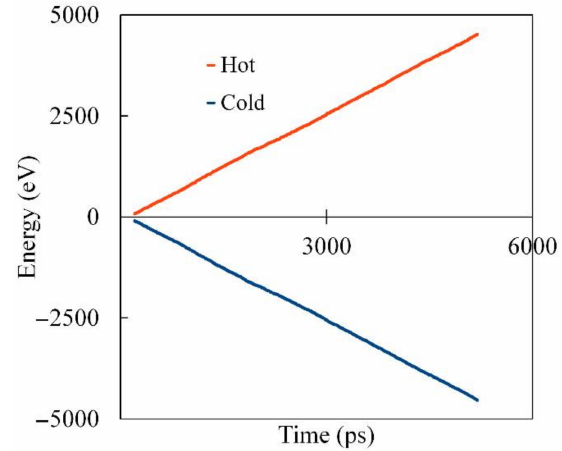
Figure 4. The energy-time graph (the energy added to the hot reservoir and removed from the cold reservoir) for a sheet with the length of 33 nm. The heat flux in Equation (5) can be calculated based on the slope of each line. The slope of two drawn linear curves must be the same because the energy added in the hot source is equal to the energy removed in the cold source during the